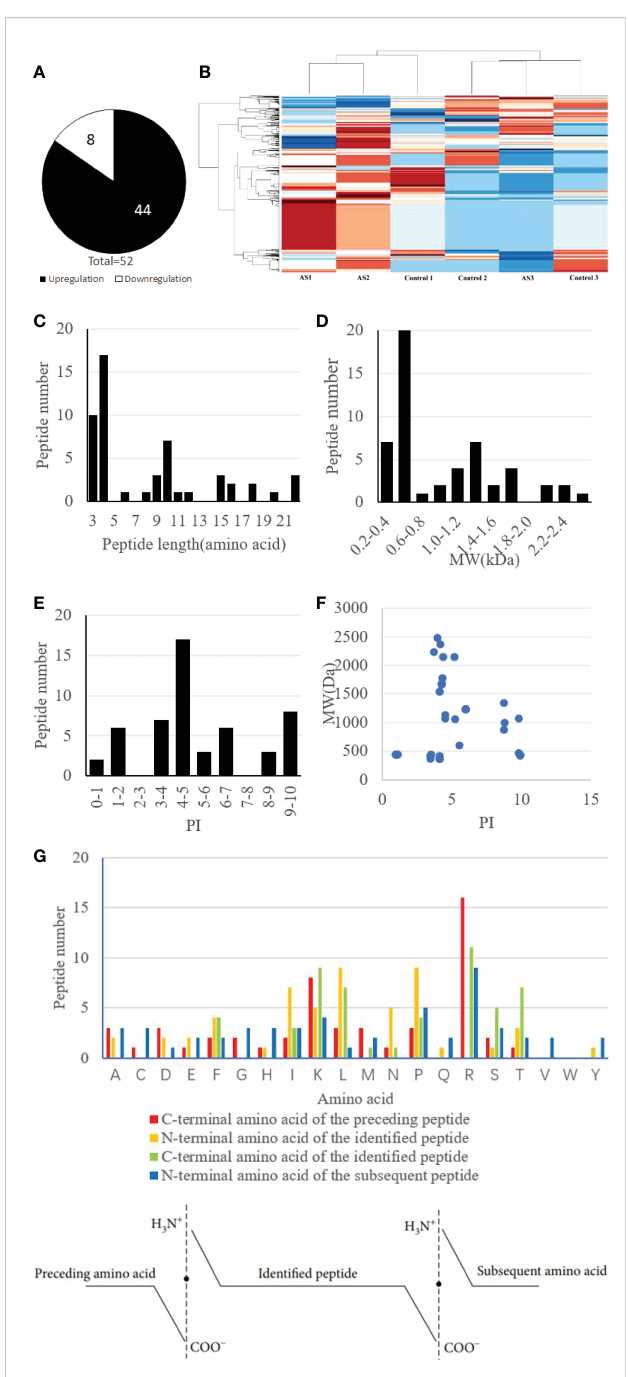
FIGURE 2 Identi fi cation and features of differentially expressed peptides. (A) Identi fi cation of the number of differentially expressed peptides. (B) Heat map of the differentially expressed peptides. (C) Distribution of the differentially expressed peptides by length. (D) Molecular weight (MW) of the differentially expressed peptides. (E) Isoelectric point (PI) of the differentially expressed peptides. (F) The correlation between the distribution of differentially expressed peptides by MW and PI. (G) Four cleavage sites of the differentially expressed